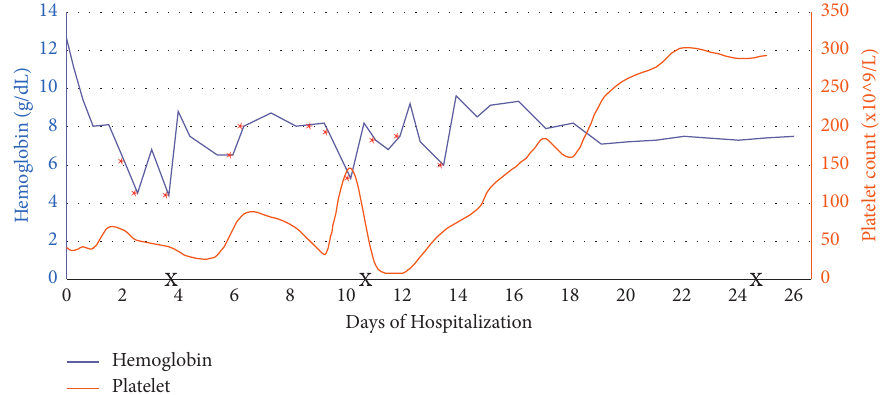
Figure 2: Trend of hemoglobin and platelets throughout the hospital course. Asterisks are reflective of red blood cell transfusions, and X is reflective of eculizumab administrations.